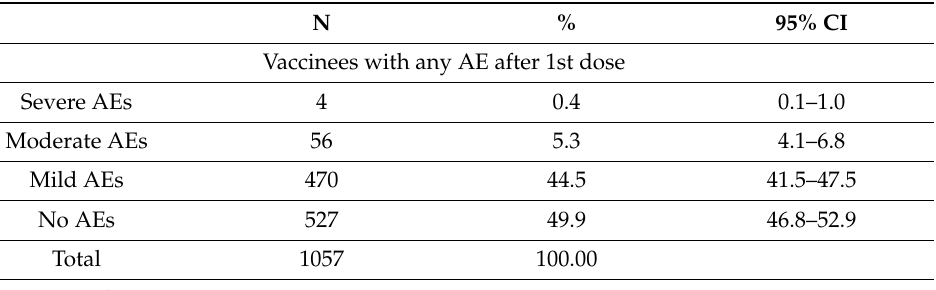
Table 4. Severity of reported post-vaccine adverse events in vaccinee participants.